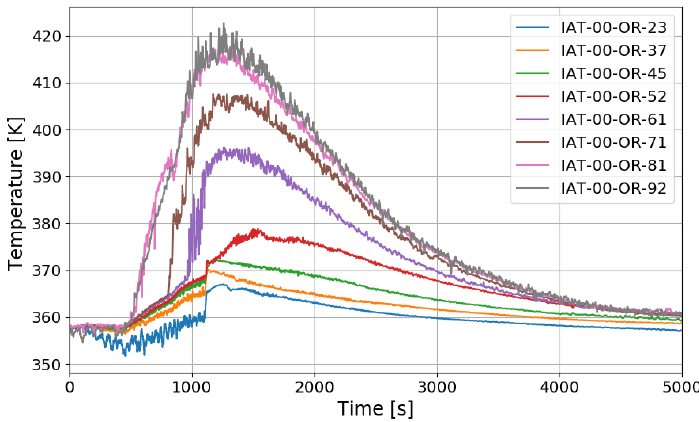
Figure 19. Temperature distributions along a center line for the SP5 test.